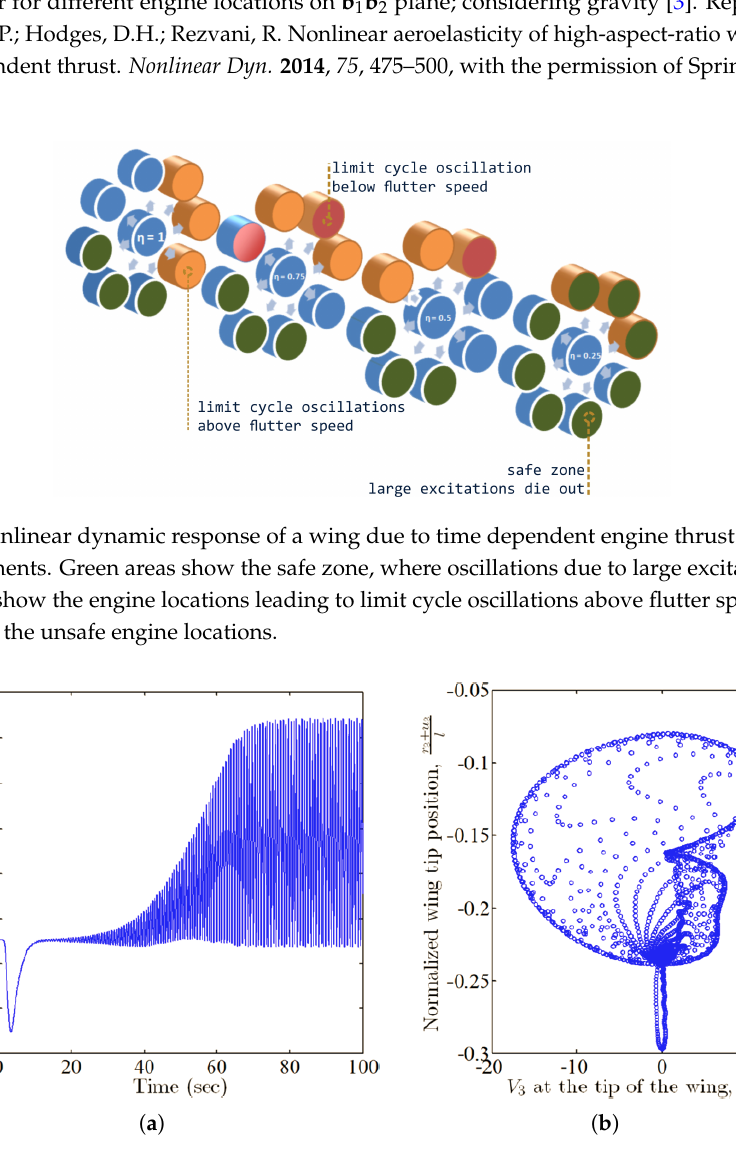
Figure 11. ( a ) Wing tip position along b 3 vs. time; ( b ) Normalized wing tip position vs. velocity in b 3 direction; engine is placed at η = 75%, r = 1, and θ = 135 ◦ [3]. Reprinted from Mardanpour, P.; Hodges, D.H.; Rezvani, R. Nonlinear aeroelasticity of high-aspect-ratio wings excited by time-dependent thrust. Nonlinear Dyn. 2014 , 75 , 475–500, with the permission of